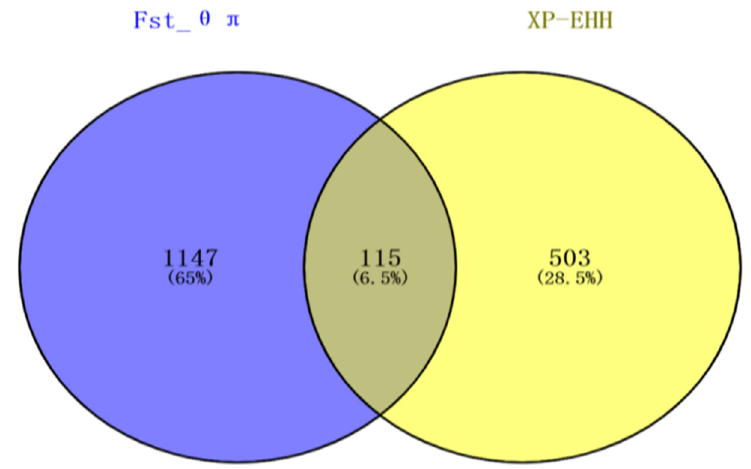
Figure 5. Overlapping SNP of Fst- θπ and XPEHH. Table 2. Candidate genes associated with hair follicle development and wool shedding traits in hair sheep.